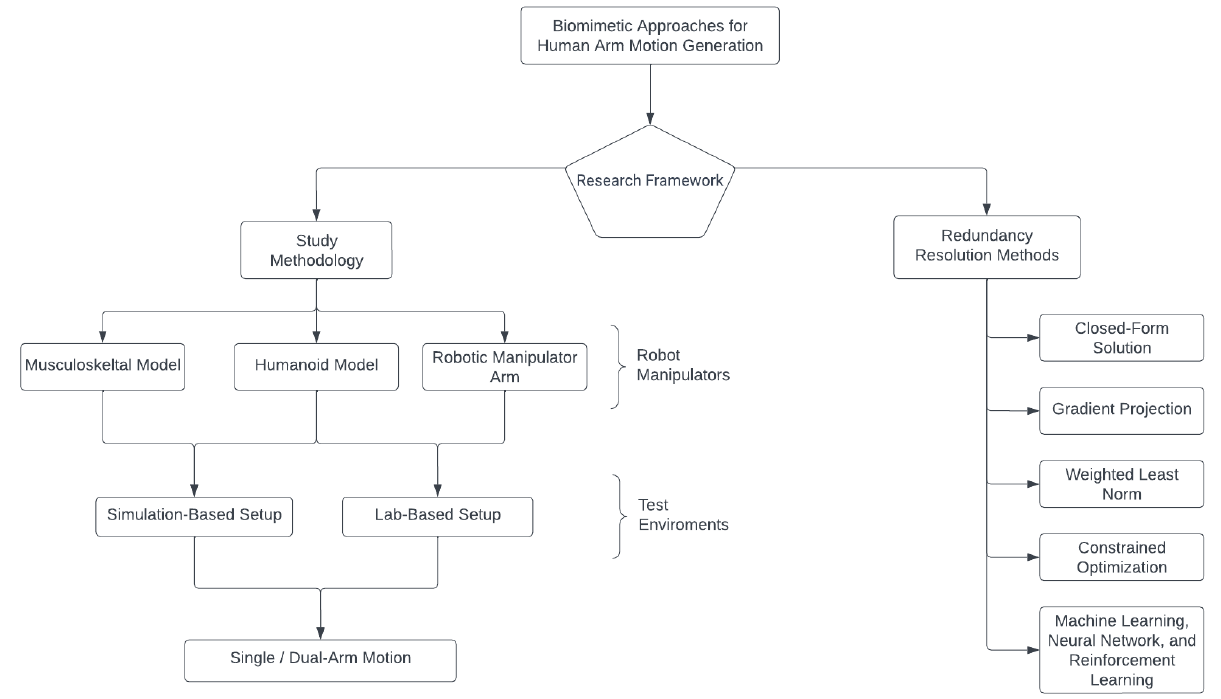
Figure 1. The organization flow chart of the literature review.